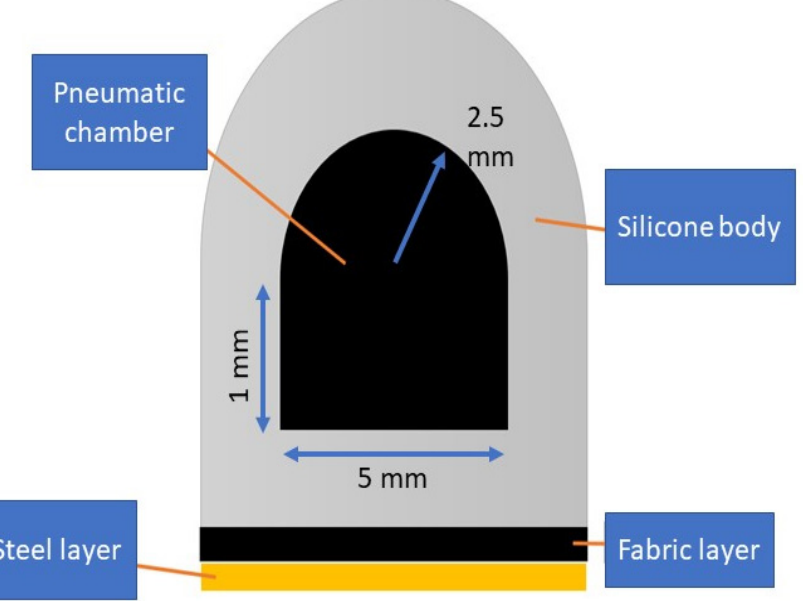
Figure 4. Diagram of the cross-sectional area of the actuator including the fabric and steel layer at the bottom.